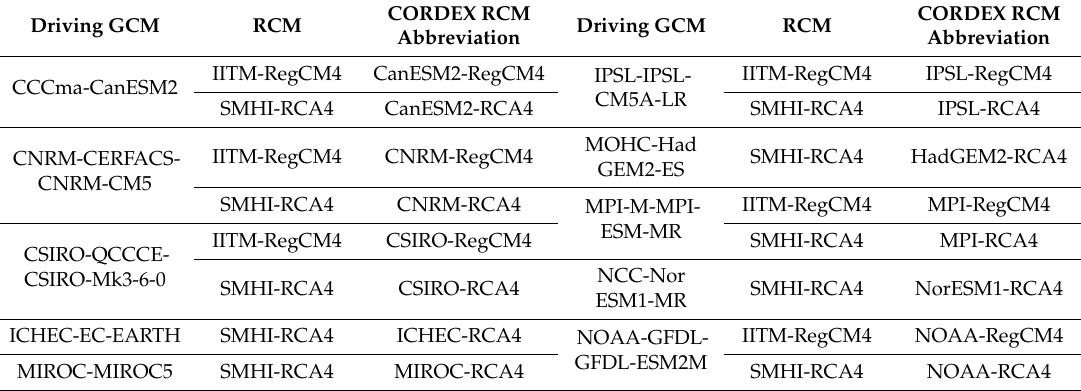
Table 2. List of WAS-44 COordinated Regional climate Downscaling EXperiment (CORDEX) GCM-RCMs combinations with the labels used in the present study and the most suitable model found in